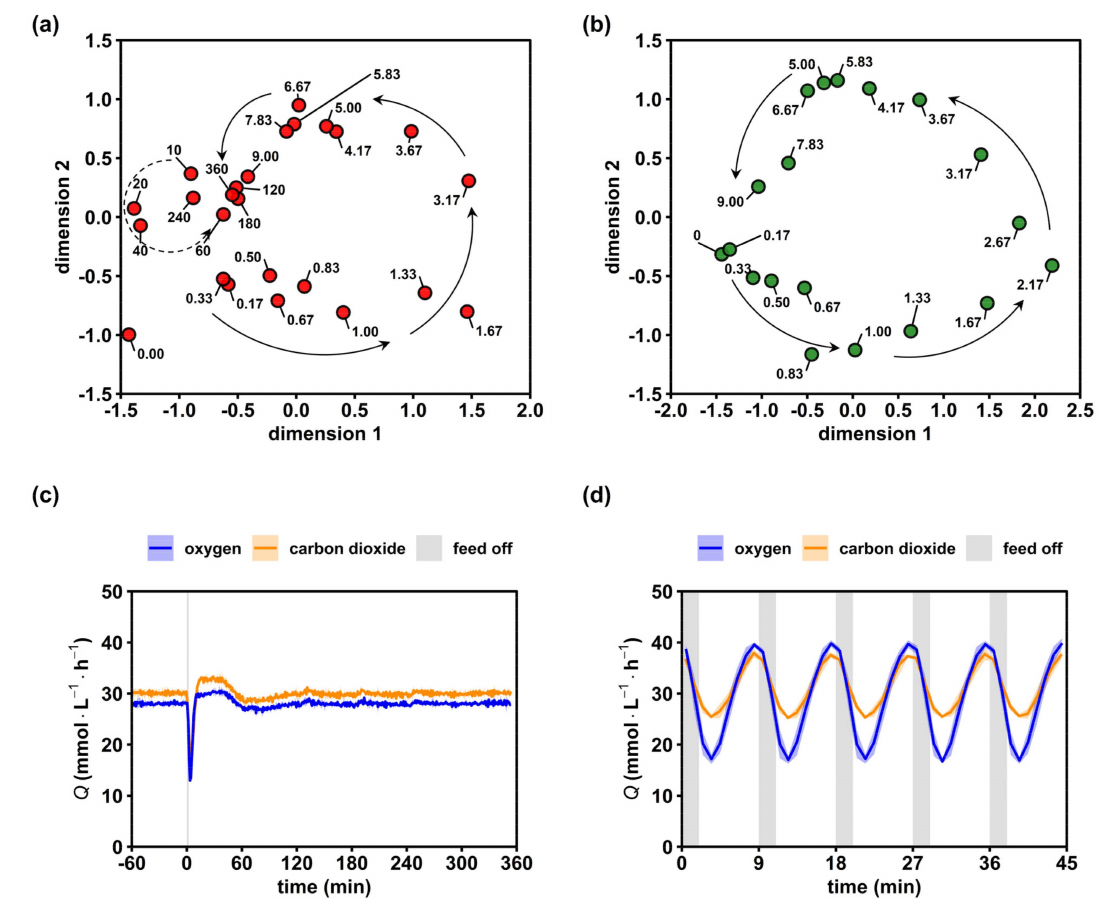
Figure 3. Relaxation of the intracellular metabolome and respiratory activity. ( a ) Multidimensional scaling (MDS) plot of the non-adapted (red) 6 h time series based on min–max normalized concen- trations of 28 intracellular metabolites. Arrows provide a visual aid to follow the short-term (solid) and mid-term (dashed) dynamics. ( b ) Analogous MDS plot of the adapted (green) 9 min time series. ( c ) Evolutions of the oxygen and carbon dioxide transfer rates after a single starvation transition. ( d ) Analogous off gas analysis over 5 perturbation cycles during the dynamic steady state. Text labels in ( a , b ) represent the sample time in minutes. Blue and orange lines in ( c , d ) represent the mean and light areas represent the respective standard deviation of three biological